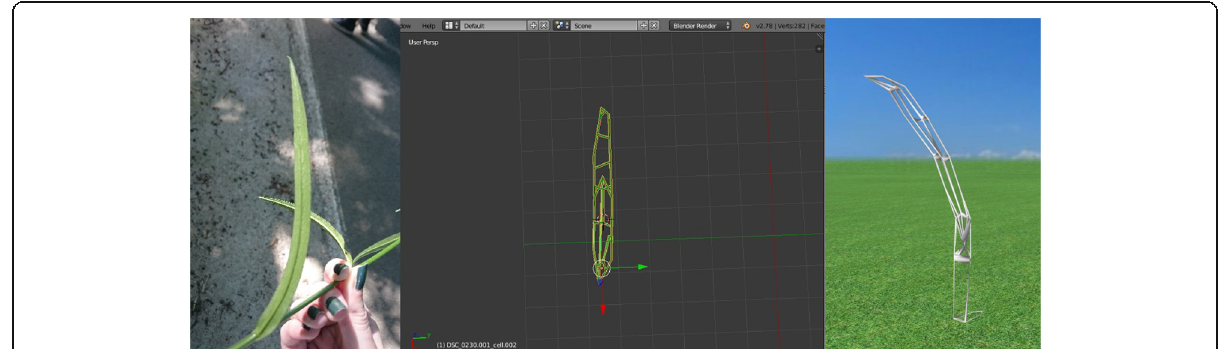
Fig. 5 Design of a 3D candelabra model using a biomimetic approach